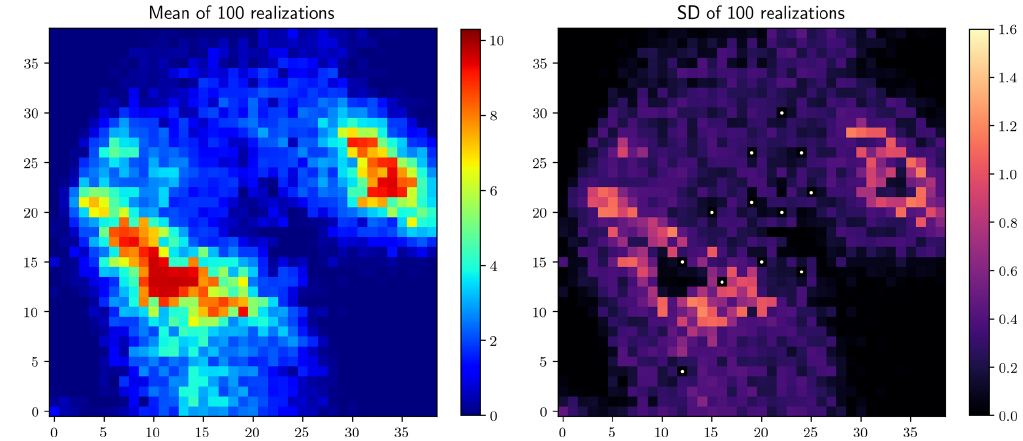
Figure 6. Stage 2 results: mean and standard deviation of 100 realizations (mm), obtained using the expected quantile map as the reference.